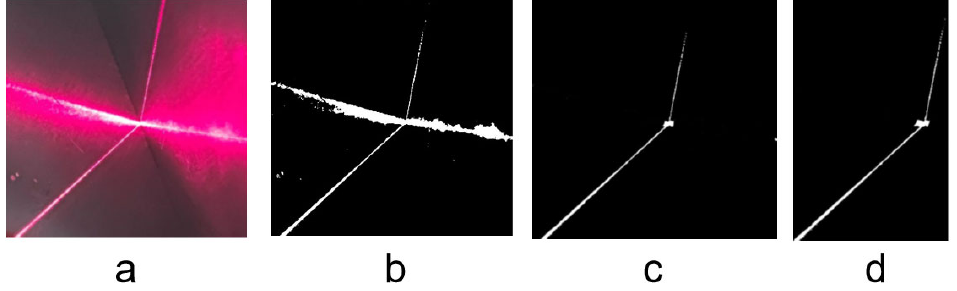
Figure 7. Image-processing flow after neural network segmentation. ( a ) original image ( b ) binariza- Figure 7. Image ‐ processing flow after neural network segmentation. ( a ) original image ( b ) tion ( c ) image after recognition by the neural network ( d ) ROI binarization ( c ) image after recognition by the neural network ( d ) ROI extraction